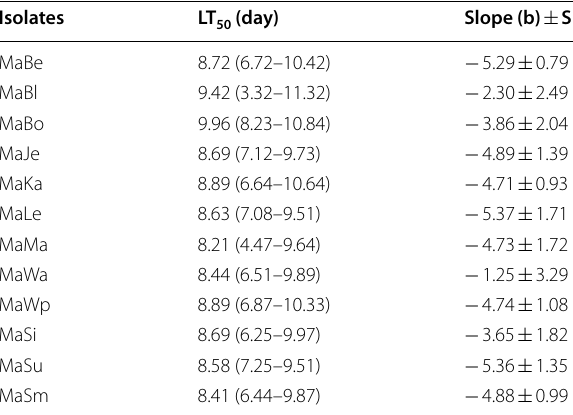
Table 5 LT with 95% confidence limits following infection of 50 Oryctes rhinoceros with Metarhizium isolates at a concentration of 10 7 conidia/ml